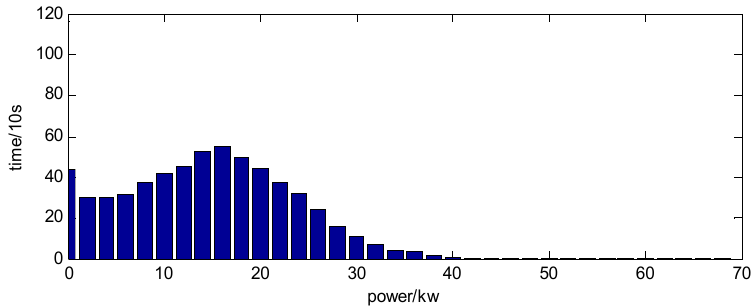
Figure 11. Operating time distribution of ESS in different charge power.